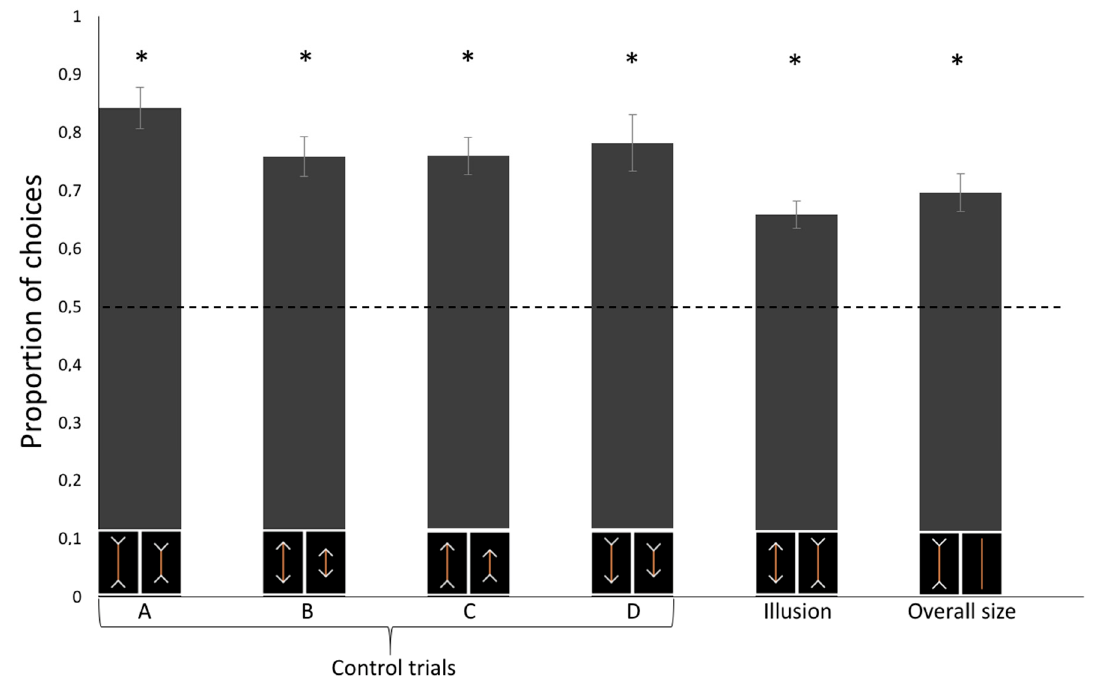
Figure 3. Proportion of correct choices plotted against the four control conditions ( A – D ) and the control for the overall size. In the test phase, the y -axis refers to the proportion of selections of carrots with inward-pointing arrowheads. Asterisks denote a significant departure from chance ( p < 0.05). Error bars represent the standard errors.